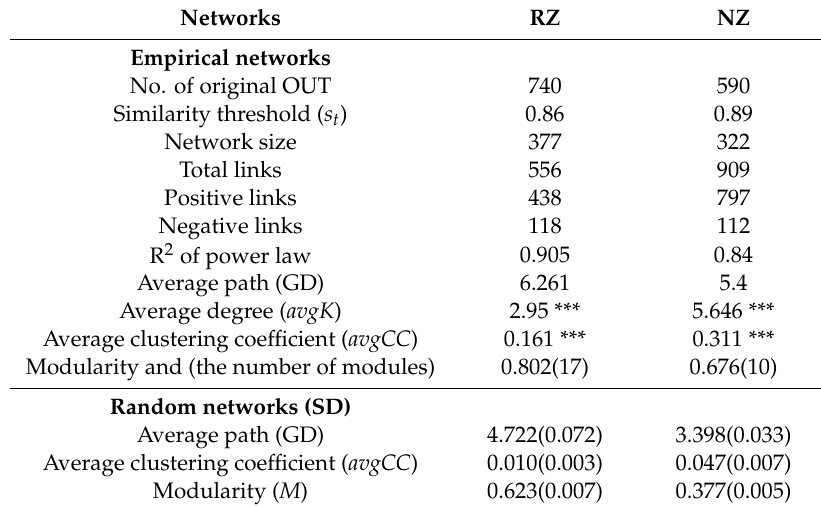
Figure 6. Zi - Pi plots showing distribution of OTUs based on their topological roles in the P. australis zone network (red square) and non- P. australis zone network (blue triangle). Threshold values of Zi and Pi for categorizing OTUs were 2.5 and 0.62. More information on the module hubs and connectors are shown in Table S5. Abbreviations: P. australi zone (RZ); non- P. australis zone (NZ).